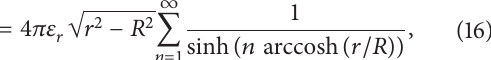
The first term of the previous equation is the electrostatic influence of the lead in which the bias voltage ( 𝑉 𝑑𝑠 ) is applied; meanwhile, the second term is the electrostatic coupling with the neighbor Qd. The neighbors capacitive matrix is defined as 𝑁 × 𝑁 symmetric matrix with zero in the diagonal terms. Both terms are multiplied by the inverse of the total Qd